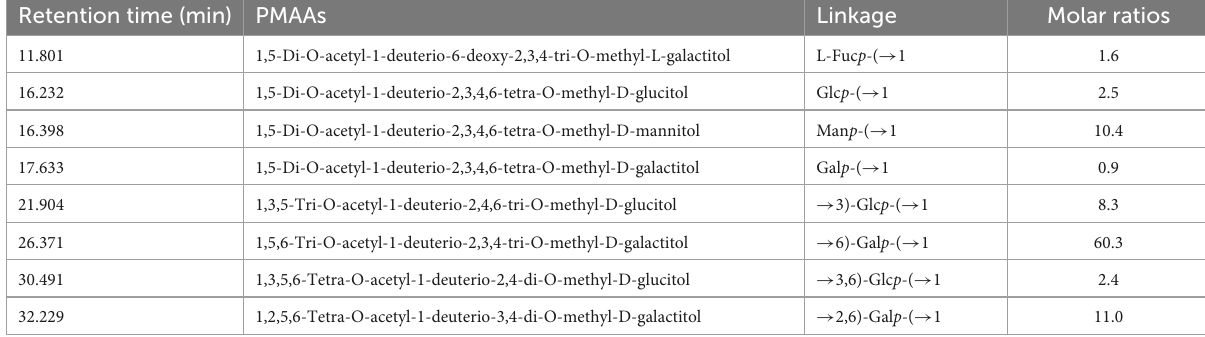
TABLE 2 Results of SRF-3 methylation